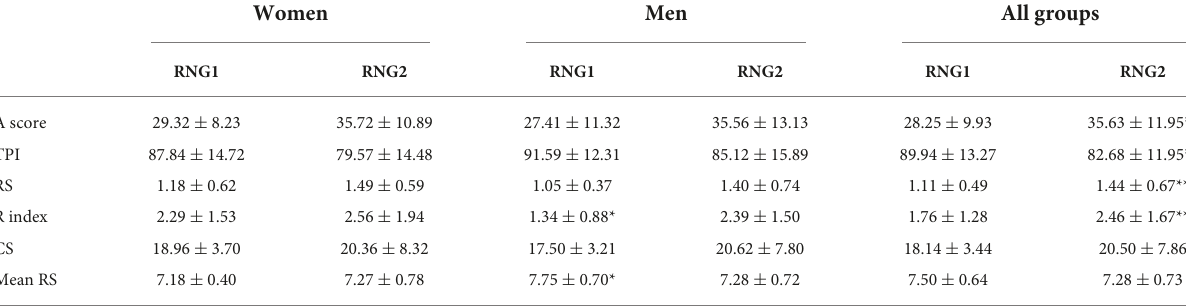
TABLE 1 Changes in executive performances as a function of difficulty and